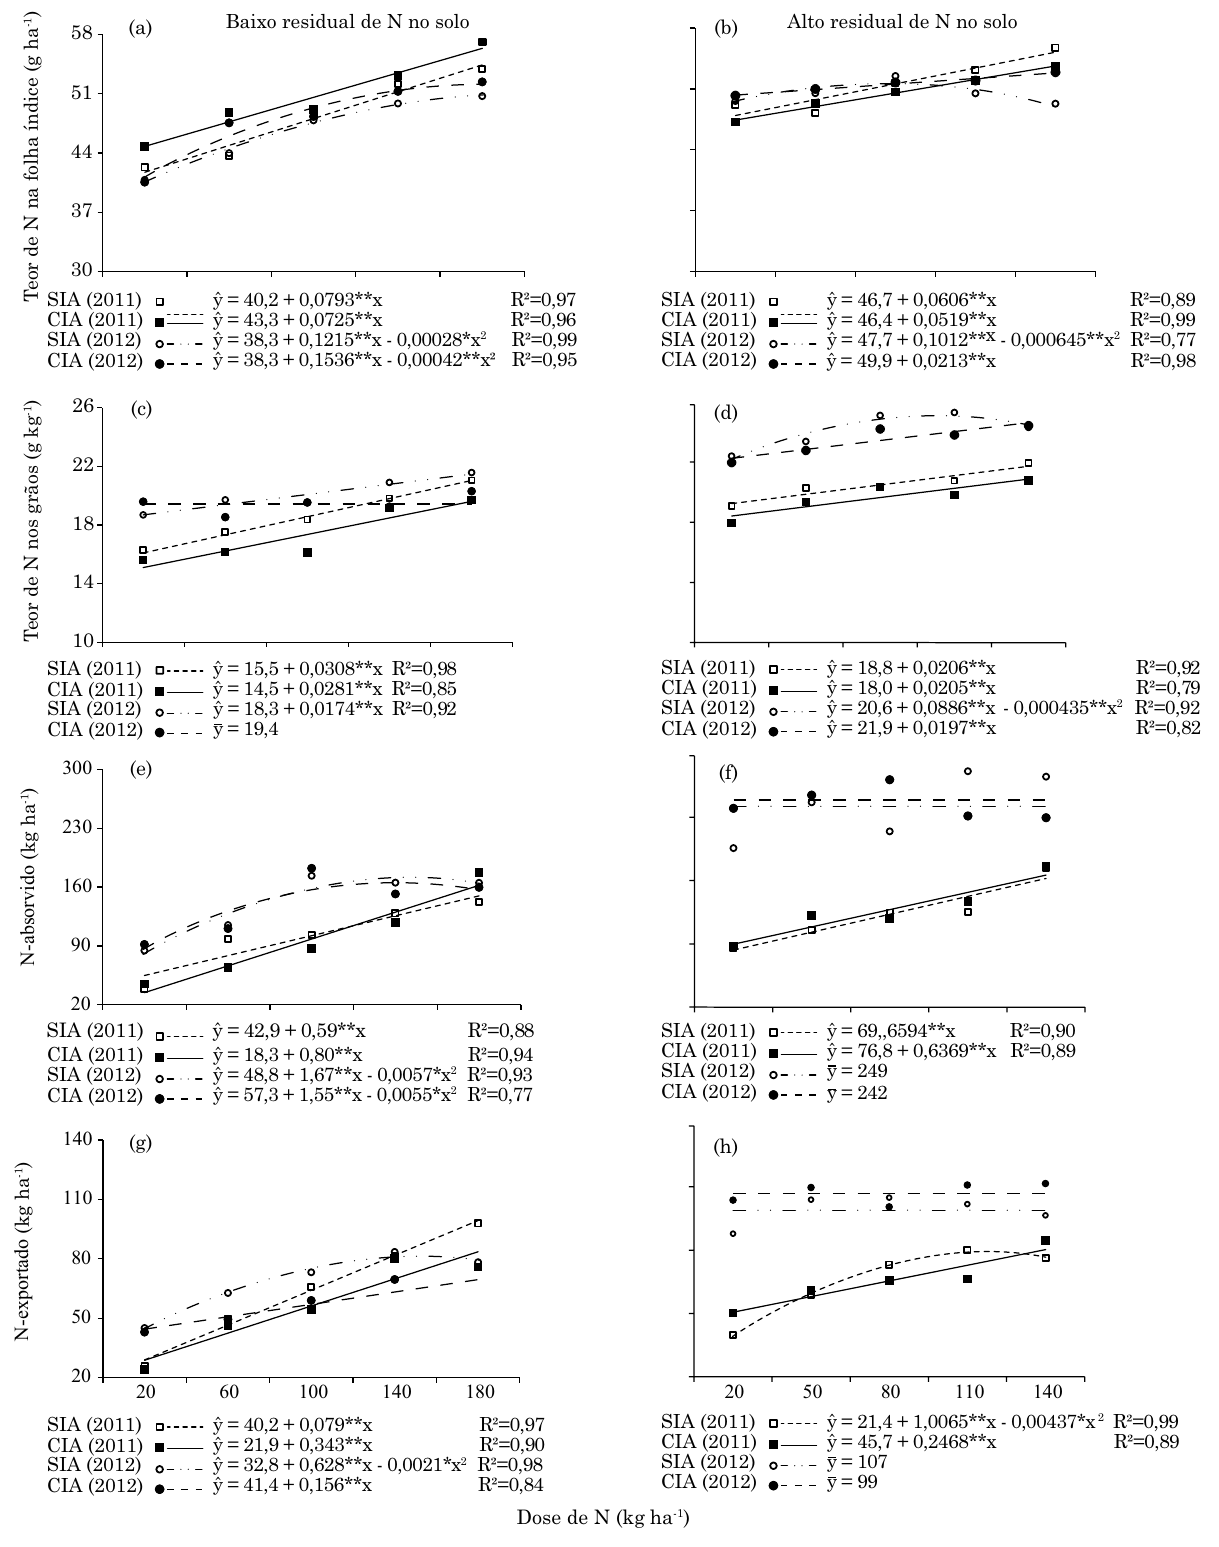
Figura 3. teor de n na folha-índice, teor de n nos grãos, n absorvido e n exportado pelo trigo em função de doses de n e da inoculação ou não com Azospirillum brasilense . ** e * significativos a 1 e 5 %, respectivamente, pelo teste t. sia: sem inoculação com Azospirillum brasilense ; e cia: com inoculação de A. brasilense